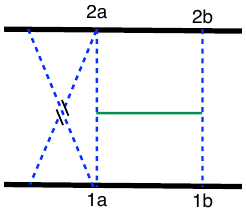
Figure 3 . Representative diagram at